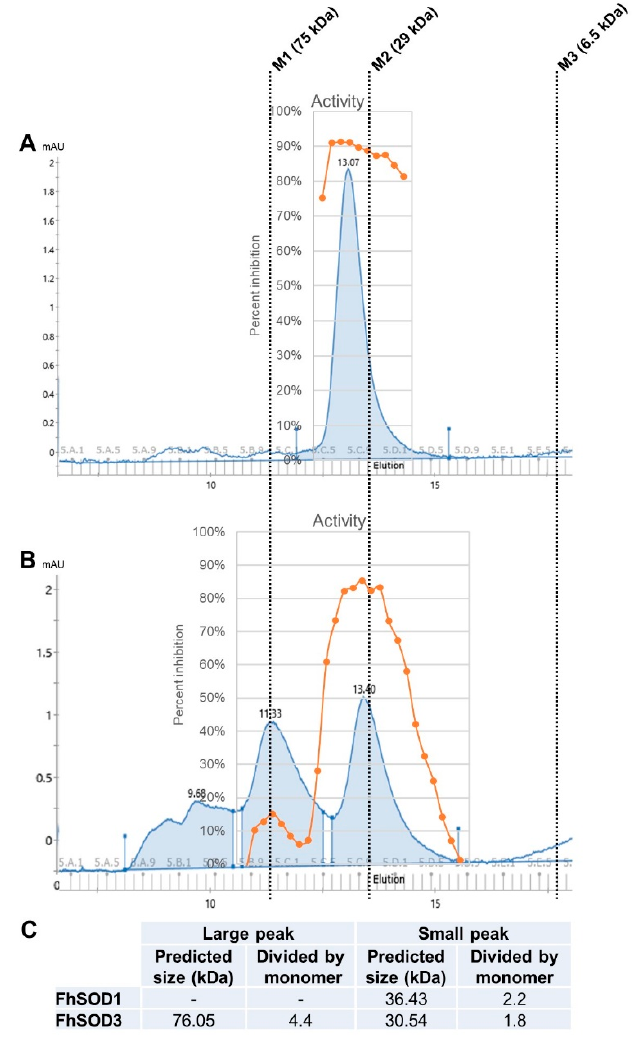
Figure 3. Structural organisation and enzymatic activity of rFhSOD1 and rFhSOD3. Size exclusion chromatography of ( A ) FhSOD1 and ( B ) FhSOD3. The corresponding enzyme activity of each elution fraction is expressed as the percentage inhibition of formazan dye formation. ( C ) The predicted molecular sizes of each recombinant protein calculated against the molecular weight markers. Markers are indicated by dotted lines—M1; conalbumin, M2; carbonic anhydrase, M3; aprotinin.